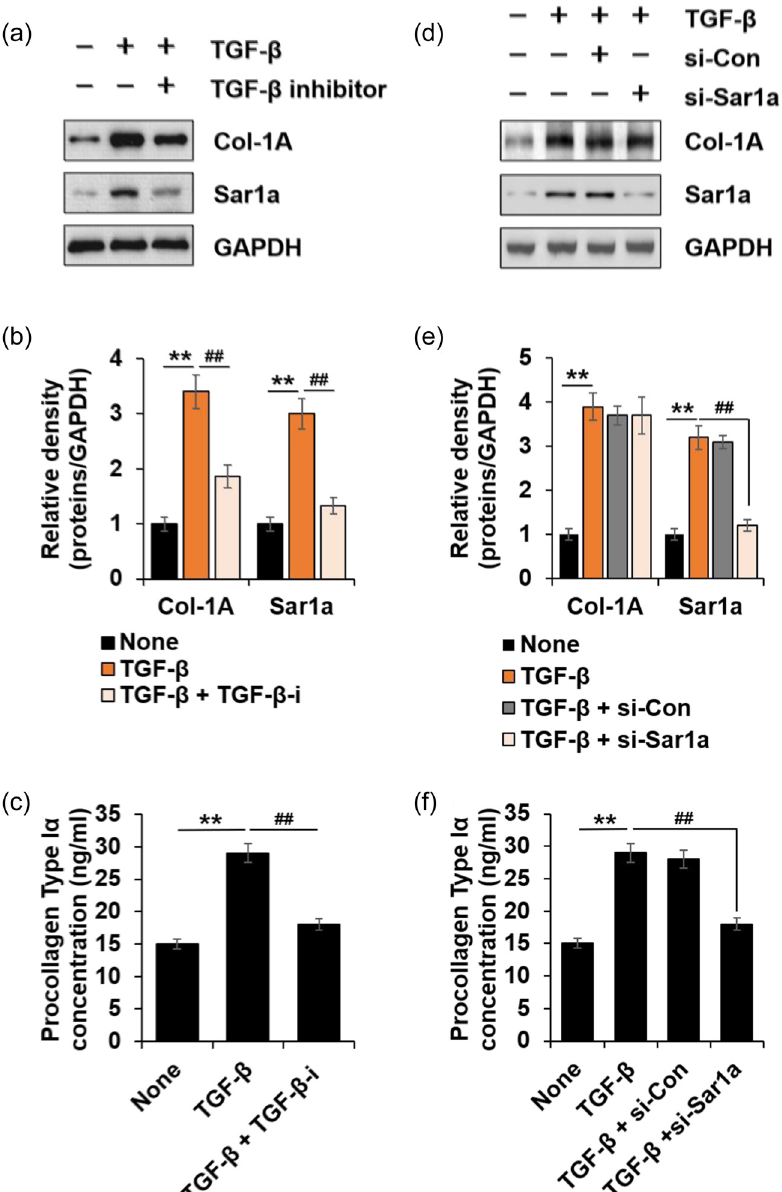
Figure 2: TGF - β 1 stimulates induction of Sar1a. HTSF and Sar1a siRNA - or a control siRNA ( si - con )- transfected HTSF were cultured in 6 - well plates, serum - starved for 16 h, and then treated with or without 10 ng/mL TGF - β 1 or TGF - β 1 + 10 μ M TGF - β inhibitor ( LY2109761 ) for 24 h. The cell culture supernatant was collected for PC - I ELISA ( c and f ) , and cell lysates were immunoblotted with antibodies against the indicated proteins ( a and d ) . ( a ) Immunoblots of Col - 1A, Sar1a, and the loading control GAPDH. ( b ) Fold change of Col - 1A or Sar1a was calculated ( n = 3, ± SD ) . None vs TGF - β 1; ** p < 0.01. TGF - β 1 vs TGF - β 1 + TGF - β - i; ## p < 0.01. ( c ) Secreted PC - I was determined via ELISA ( n = 3, ± SD )